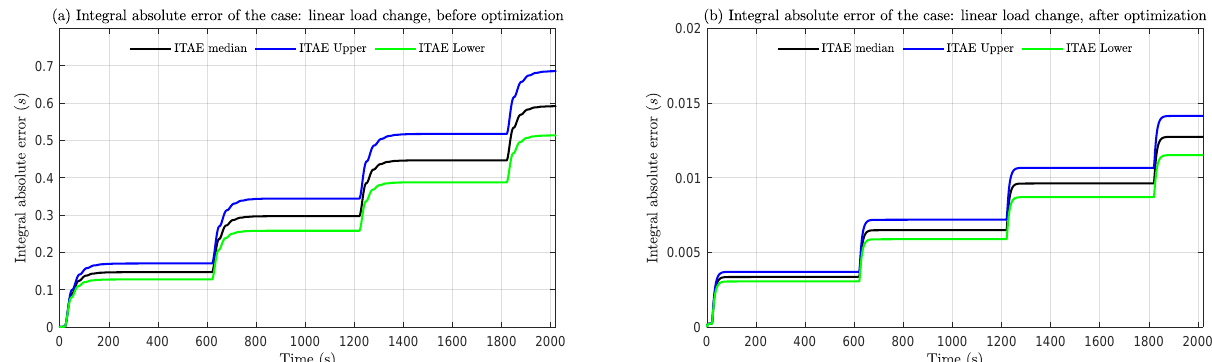
Figure 20. Integral absolute error of the case of linear load change: ( a ) before optimization; ( b ) after optimization.